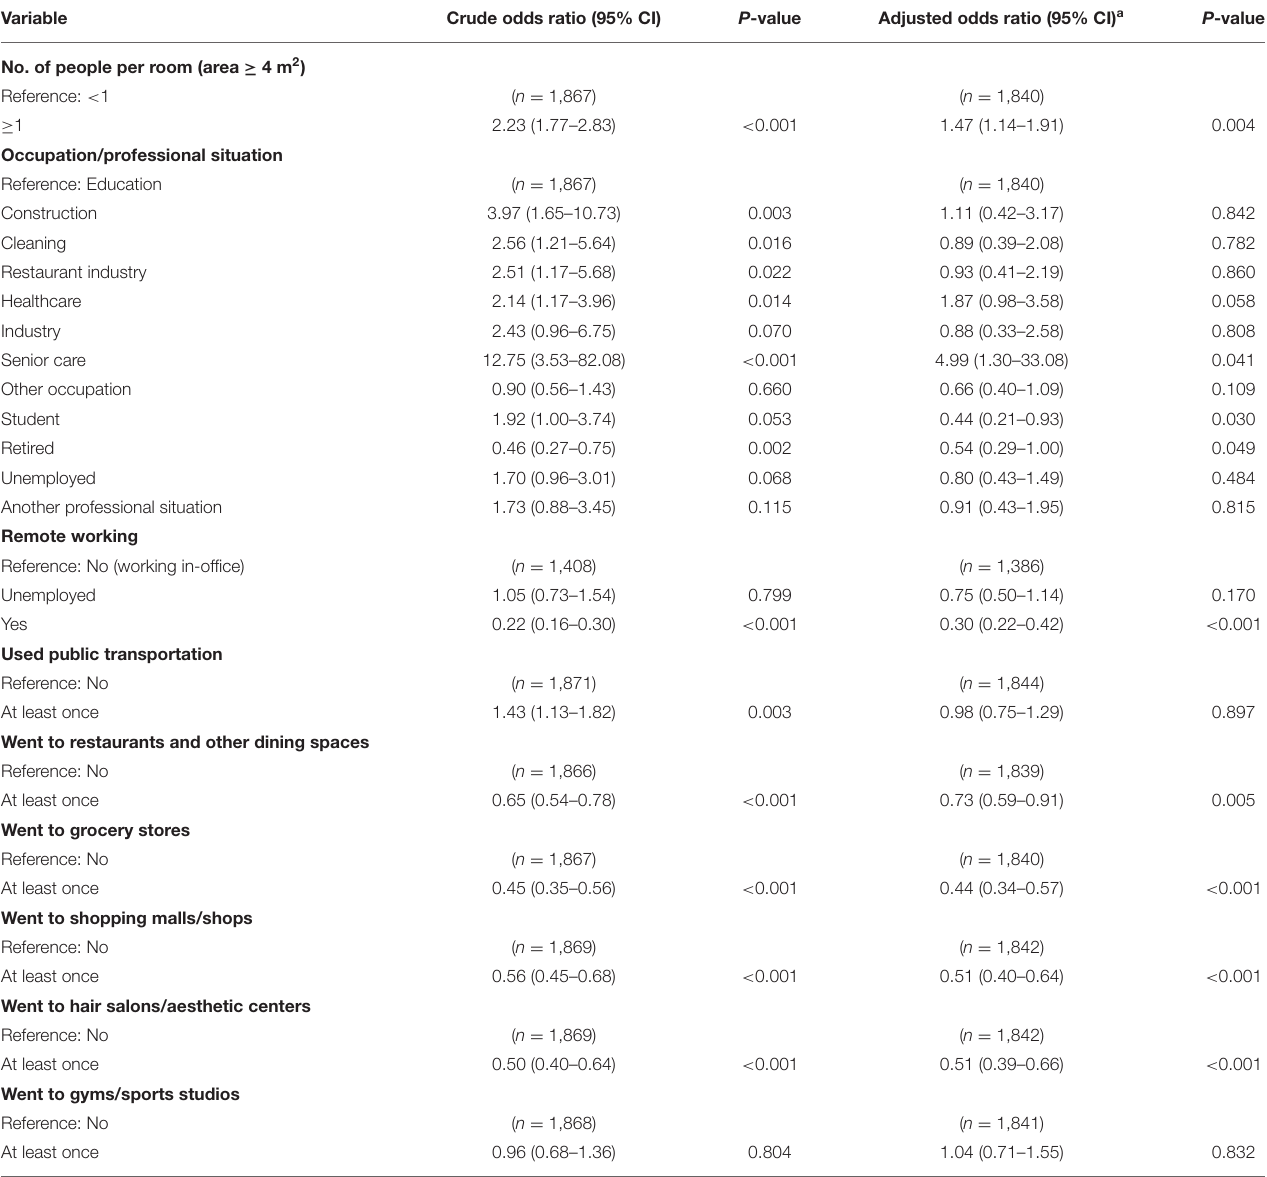
TABLE 3 | Risk of infection of SARS-CoV-2 among cases and controls from the Lisbon and Tagus Valley Region in September and October 2020. Variable Crude odds ratio (95%